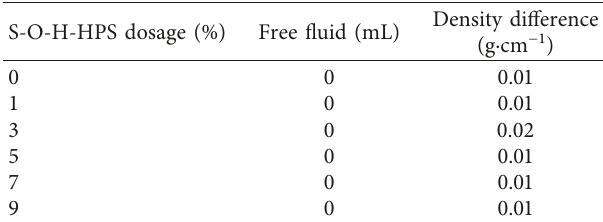
Table 5: Effect of S-O-H HPS dosage on the stability of cement slurry.